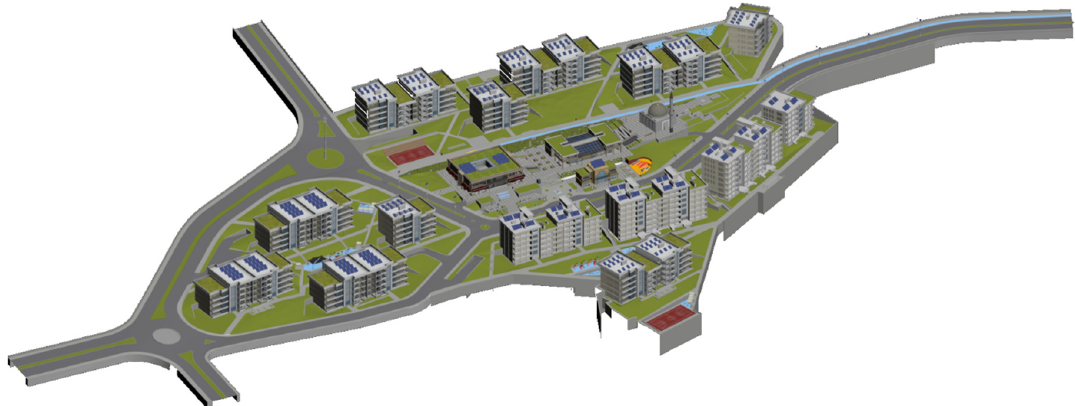
Figure 11. A part of the future city concept model in 3ds Max tool.